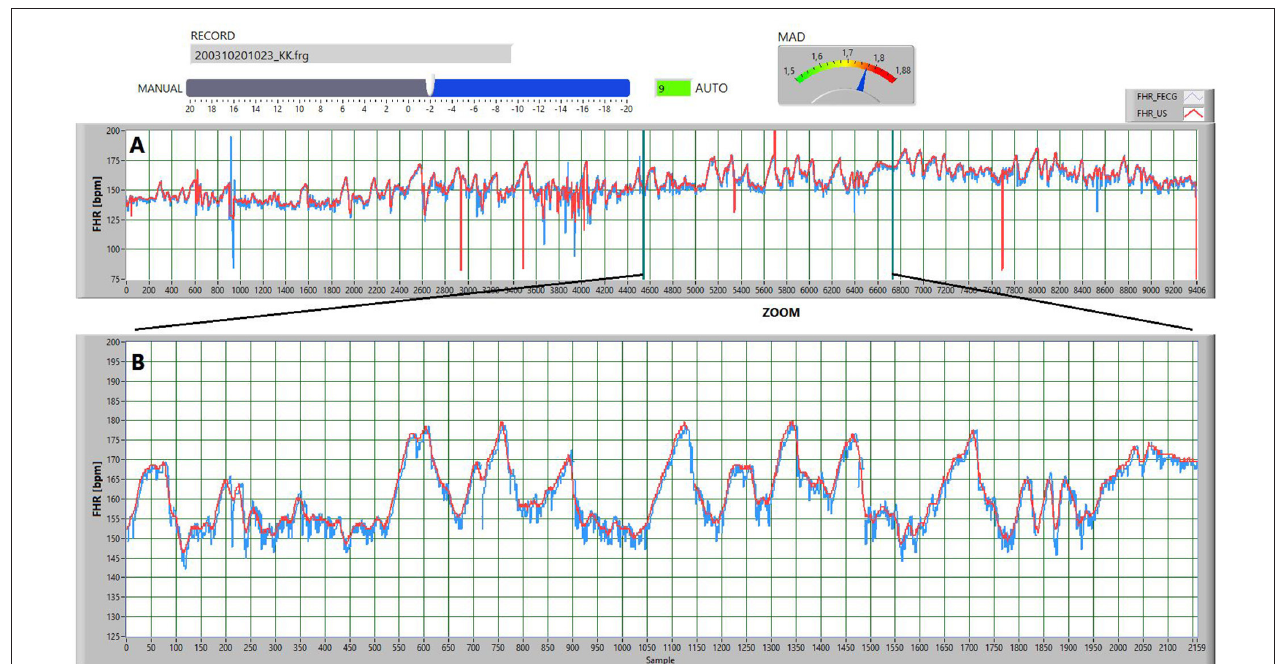
FIGURE 1 | The screen illustrating the operation of the procedure for synchronizing the two signals, determined via the ultrasound (red FHR_U) and electrocardiographic (blue FHR_E) methods. (A) Presents the concept of automated synchronization via minimizing the mean error. The current value of the mean absolute difference MAD parameter is displayed on the gauge. Auto mode had automatically set up the value of the shift parameter to 9 samples forward. However, basing on a visual analysis of the signals, that shift was manually corrected using a slider—the FHR_U signal was shifted by 2 samples backward in relation to the FHR_E signal. (B) Shows the enlarged signal fragment from part A, but after a procedure for removing the sudden FHR changes. It allows for additional manual synchronization and final validation of the recording for further investigations.